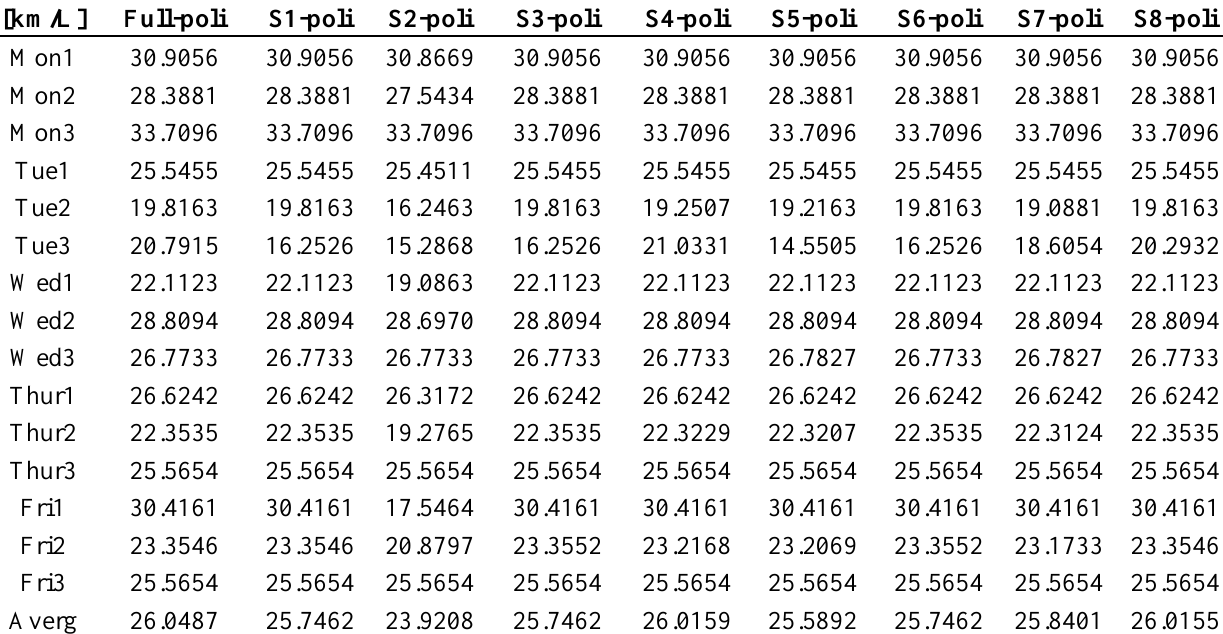
Table 2. Comparison of fuel-electricity consumption between the full-policy and single